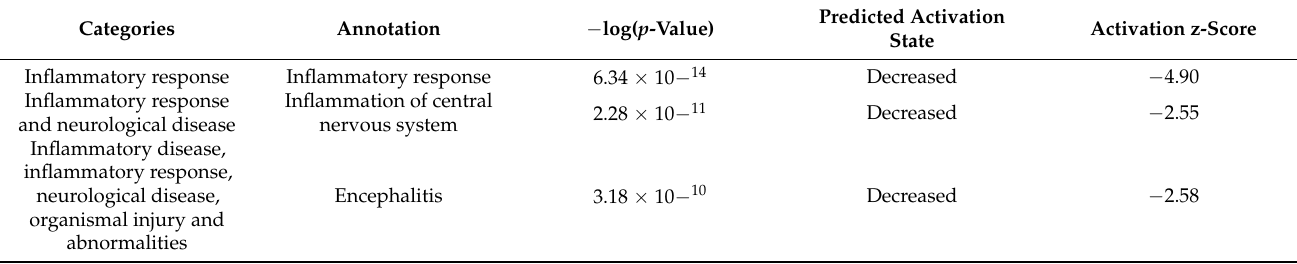
Table 5. Diseases and Functions list by IPA for w/ TNF α